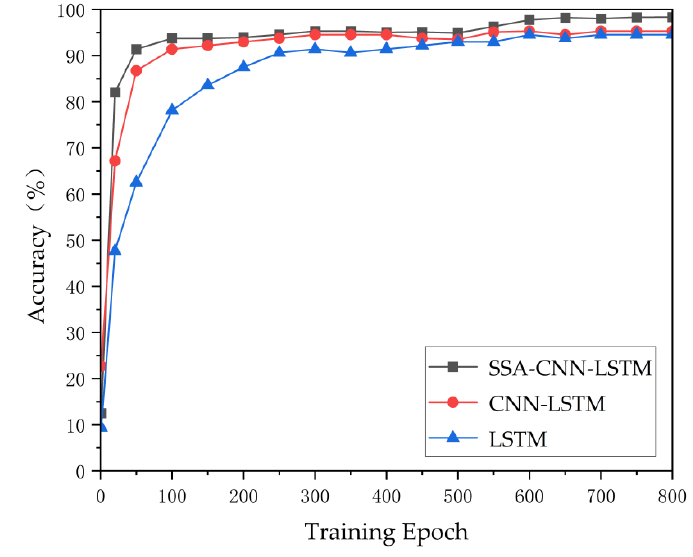
Figure 7. Accuracy of the training dataset.